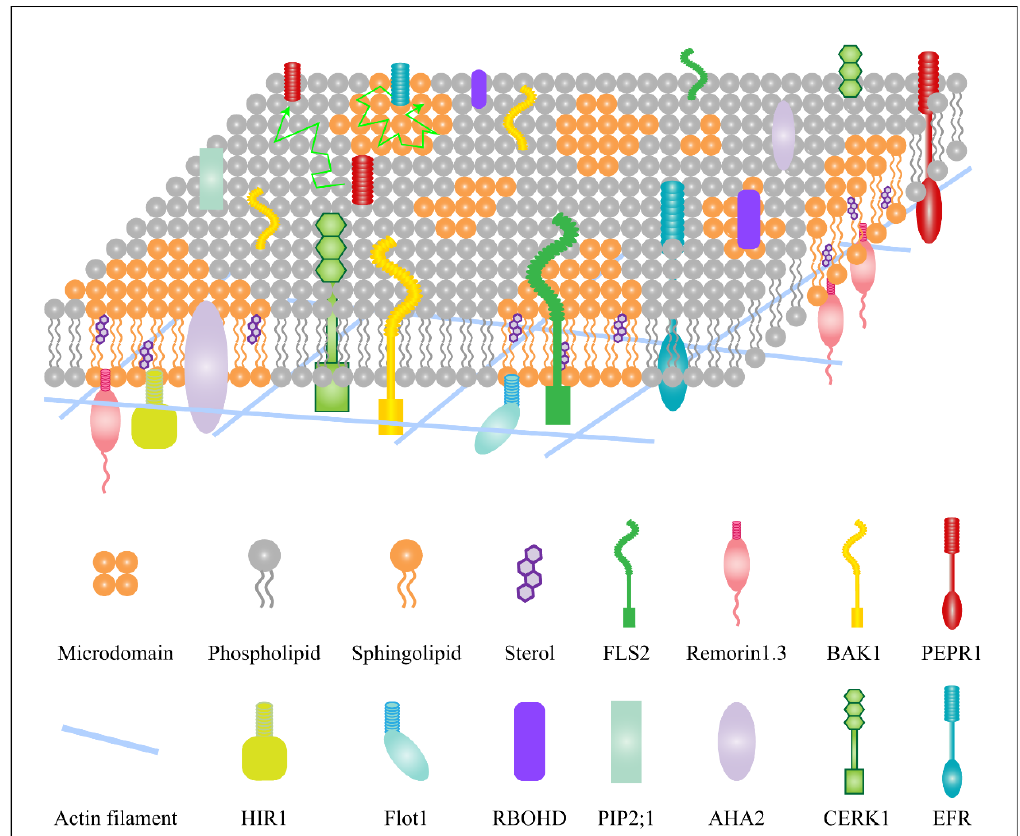
Figure 1. The cytoskeleton is involved in regulating the dynamics and organization of the plasma membrane. The plasma membrane is divided into membrane compartments by the actin cytoskeleton; the membrane compartments’ size is less than 250 nm. The diffusion of PM protein is restricted by the cytoskeleton. The PM proteins have enough free space and kinetic energy to jump to the adjacent compartment. The green line indicates the track route of PM protein movement.